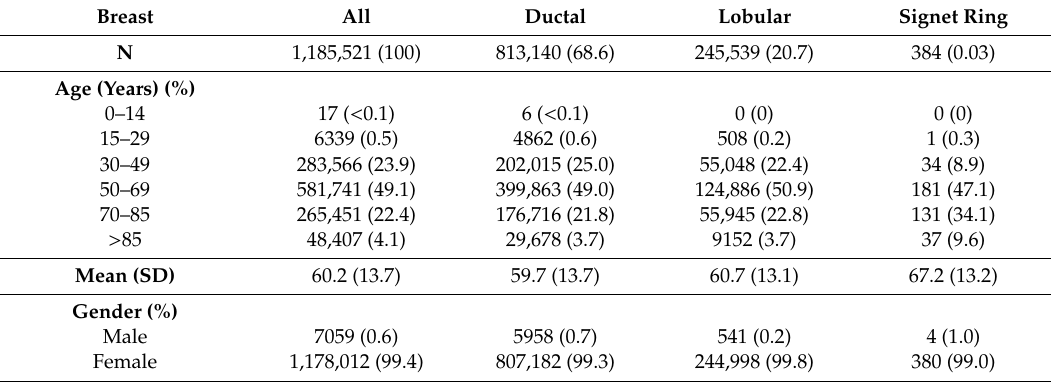
Table 17. Baseline demographics and clinical characteristics by histology for breast cancers. Breast All Ductal Lobular Signet